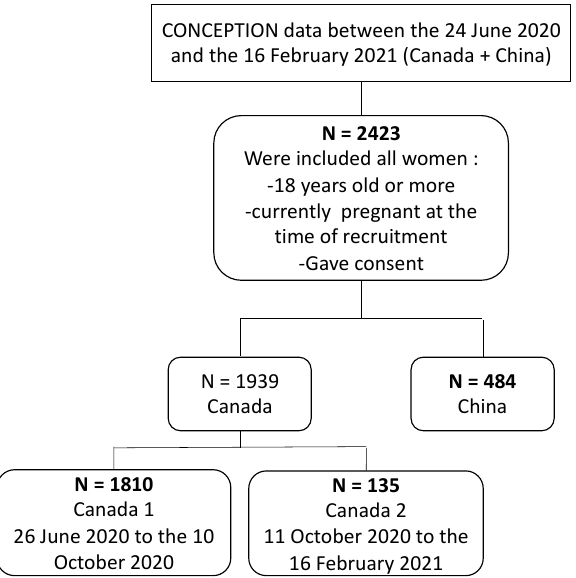
Figure 1. Flow chart of CONCEPTION included pregnant participants. Pregnant persons were on average 31.6 years old (standard deviation [SD, 4.4]) but were significantly younger in China (30.2 [SD, 4.4], p < 0.001) (Table 1). Gestational age at recruitment also differed significantly among cohorts with a mean of 33.3 weeks of gestation (SD, 7.7) in the Chinese cohort vs. 24.7 (SD, 9.8) and 20.7 (SD, 9.5) weeks in the Canada 1 and Canada 2 cohorts, respectively (Table 1). Overall, 87.7% of Chinese participants were recruited in their 3rd trimester compared to 45.9% ( p < 0.001) and 25.9% ( p < 0.001) in the Canada 1 and Canada 2 cohorts, respectively (Table 1). Canadian participants were less likely to be cared for by obstetricians during their pregnancy than in China (Canada 1: 55%/Canada 2: 52.6% vs. China: 96% p < 0.001). Moreover, education level was higher among Canadian participants (Canada 1: 16.8 years of education [SD, 4.5], Canada 2: 15.8 [SD, 6.1] and China: 14.4 [SD, 3.1], p < 0.001) (Table 1). In terms of employment status, only 59.1% of Chinese participants were employed ( p < 0.001 compared to Canada 1 and Can- ada 2) and 32.1% of them were not employed (vs 1.9% Canada 1 and 0.8% Canada 2, p < 0.001). Differences in area of residence were also noticed with most Chinese participants living in an urban area (88.1% vs. 40.9% Canada 1 and 53.1% Canada 2, p < 0.001) (Table 1). Finally, OTC medication use was more common in Canada during pregnancy with 67.1% (Canada 1) and 60.2% (Canada 2) of participants reported taking OTC medication while pregnant when only 5.4% of participants in China did (Supplementary File S1). Pregnancy history data of pregnant participants is presented is Table 2 . Alcohol and smok- ing habits as well as drug use and physical activity of included participants are presented in Supplementary File S1.